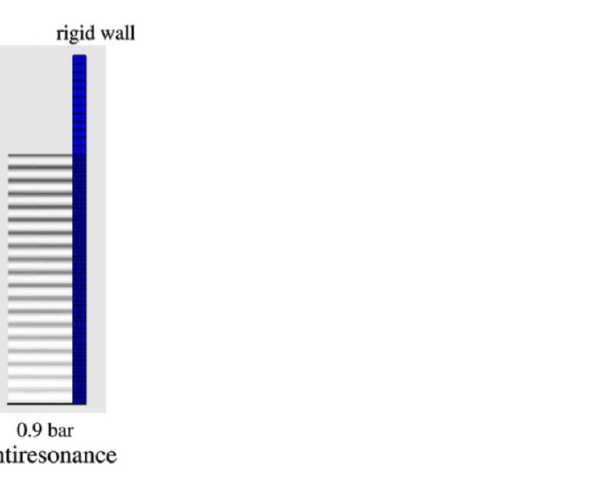
Figure 22. The calculated spatial distribution of the acoustic amplitude for the resonance liquid height (13.875 cm) and the antiresonance one (14.25 cm) for the rigid wall [66]. The bottom plate vibrates spatially uniformly. The attenuation coefficient is 5 m − 1 . Copyright 2007, with the permission from Elsevier.